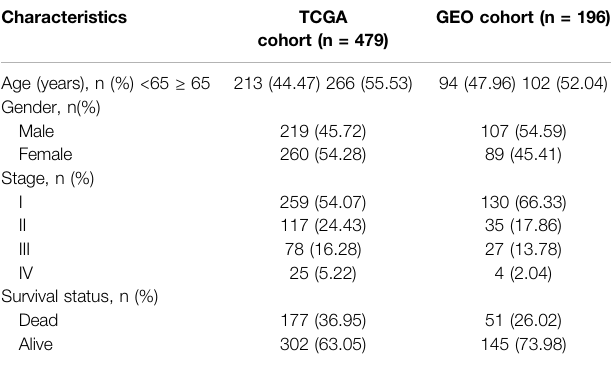
TABLE 2 | Clinicopathological parameters of TCGA cohort and GEO cohort.